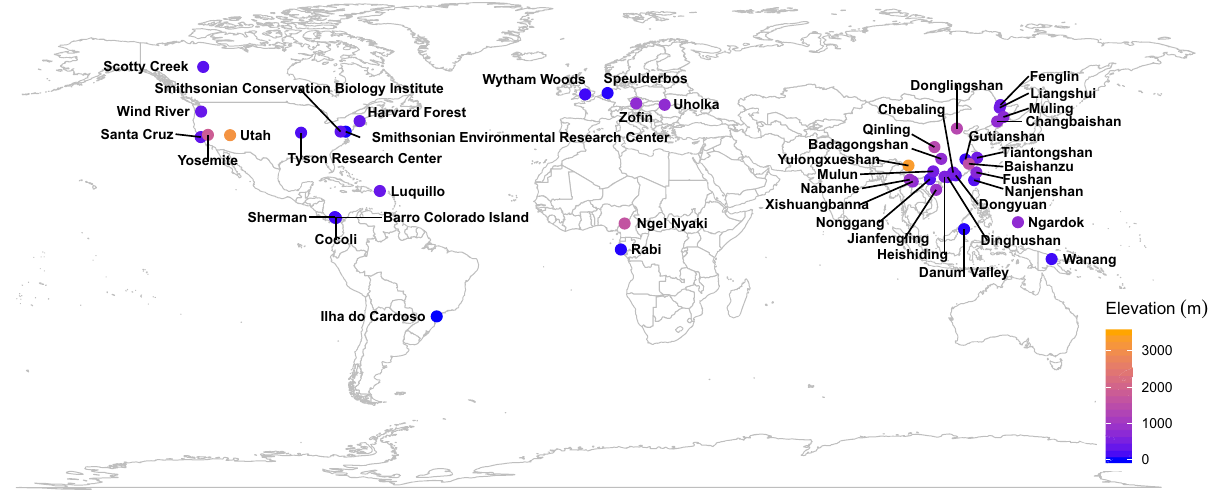
Fig. 1 Global distribution of 45 forest plots. Plots range in size from 2.1ha (Nanjenshan) to 60ha (Jianfengling) and in latitude from 21.5°S (Ilha do Cardoso, Brasil) to 61.3 °N (Scotty Creek, Canada), covering all continents with forests (i.e., Asia, Africa, Europe, South America, North America,